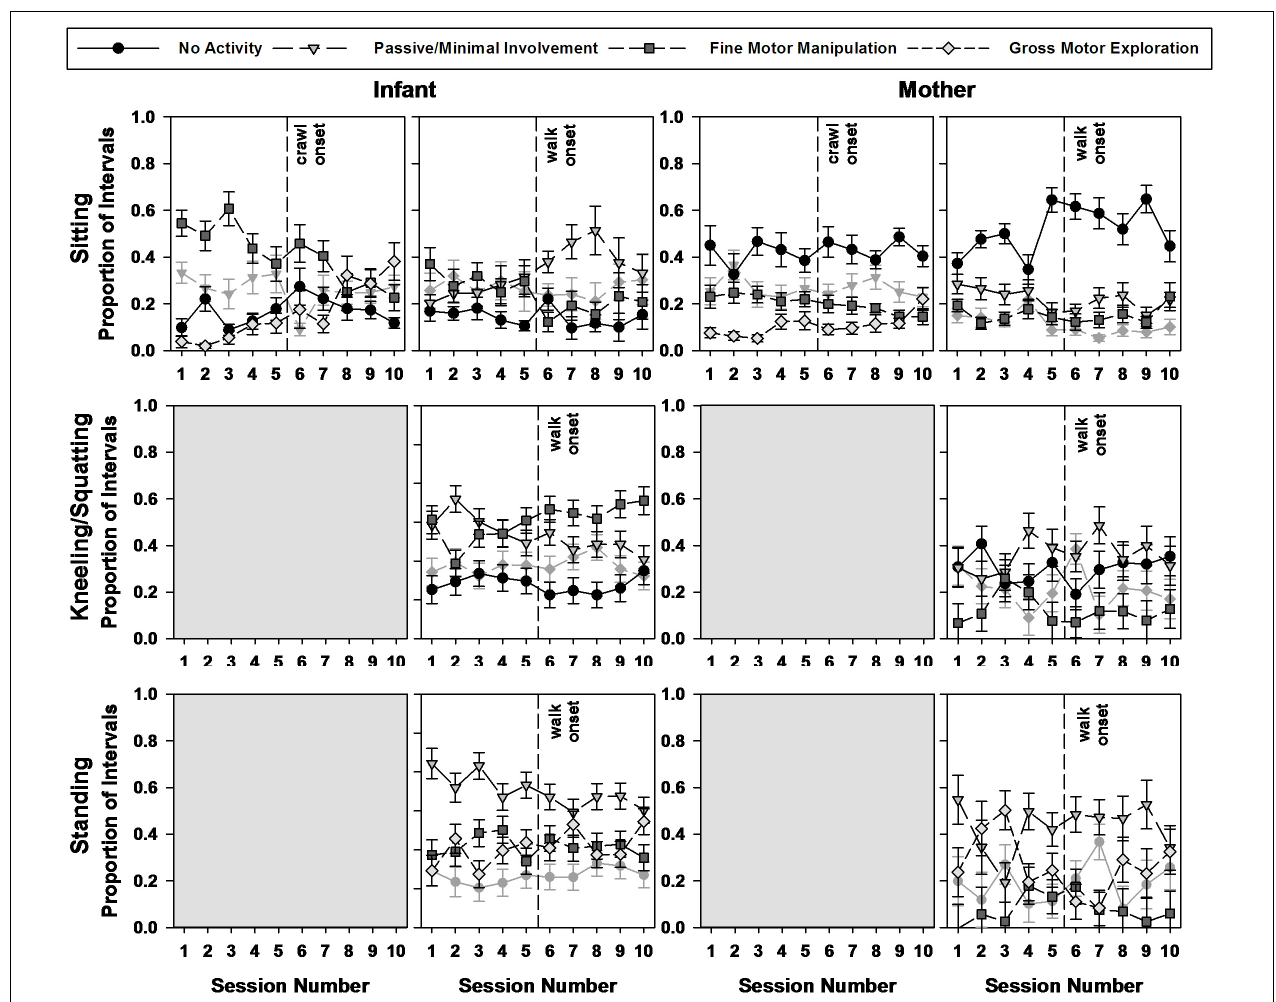
FIGURE 6 | Mean proportions and standard errors of infants’ and mothers’ interactive behaviors by posture, by type of interactive behavior, by session number across the transition to crawling and walking, and by dyad member. The vertical lines on the graphs indicate the onsets of crawling and walking, respectively. The lines that are grayed out were not entered in the GEE analyses but are still plotted for illustration